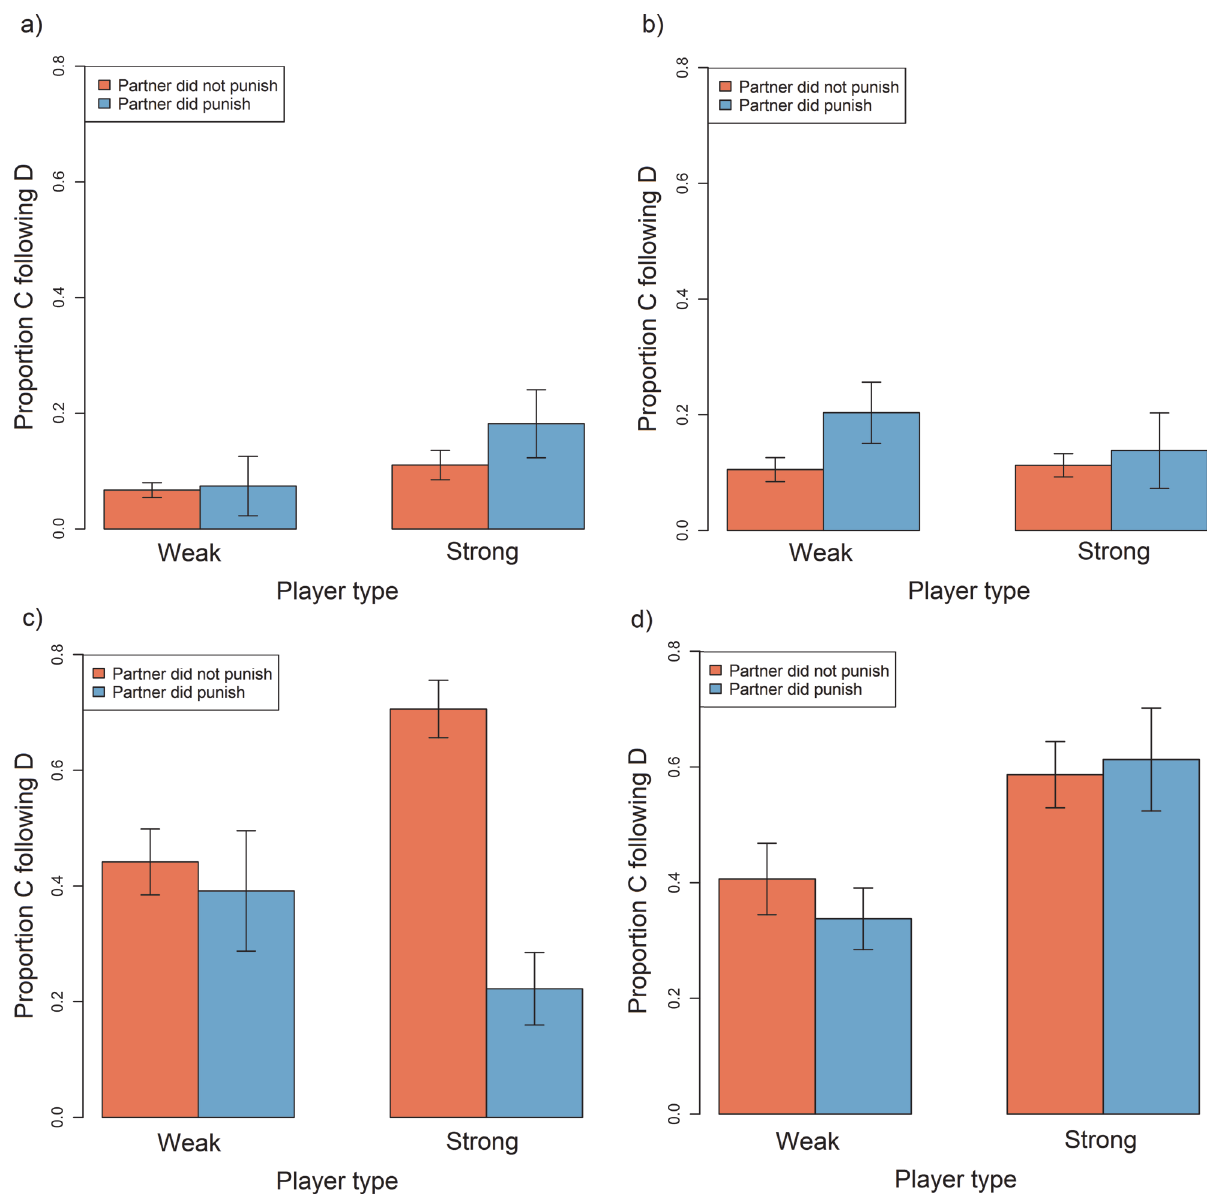
Fig 3. Barplot showing the proportion of instances in which players cooperated following defecting in the previous round, according to whether they were weak or strong and whether they were punished by their partner in the previous round. Data is shown for players in a) symmetric games where the partner defected in the previous round b) asymmetric games where the partner defected in the previous round c) symmetric games where the partner cooperated in the previous round and d) asymmetric games where the partner cooperated in the previous round. Data were restricted to instances in which the player defected in the previous round, excluding rounds where either player opted out or was bankrupt. Error bars represent standard errors. Plots are generated from raw